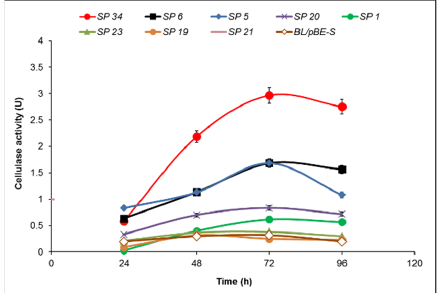
Figure 5. Time course of cellulase activity of B. licheniformis recombinant clones containing the pBES_cel8A construct with a library of signal peptides compared to B. lichenifromis 24 transformed with pBE-S vector (control). The data are mean values from two batch processes.